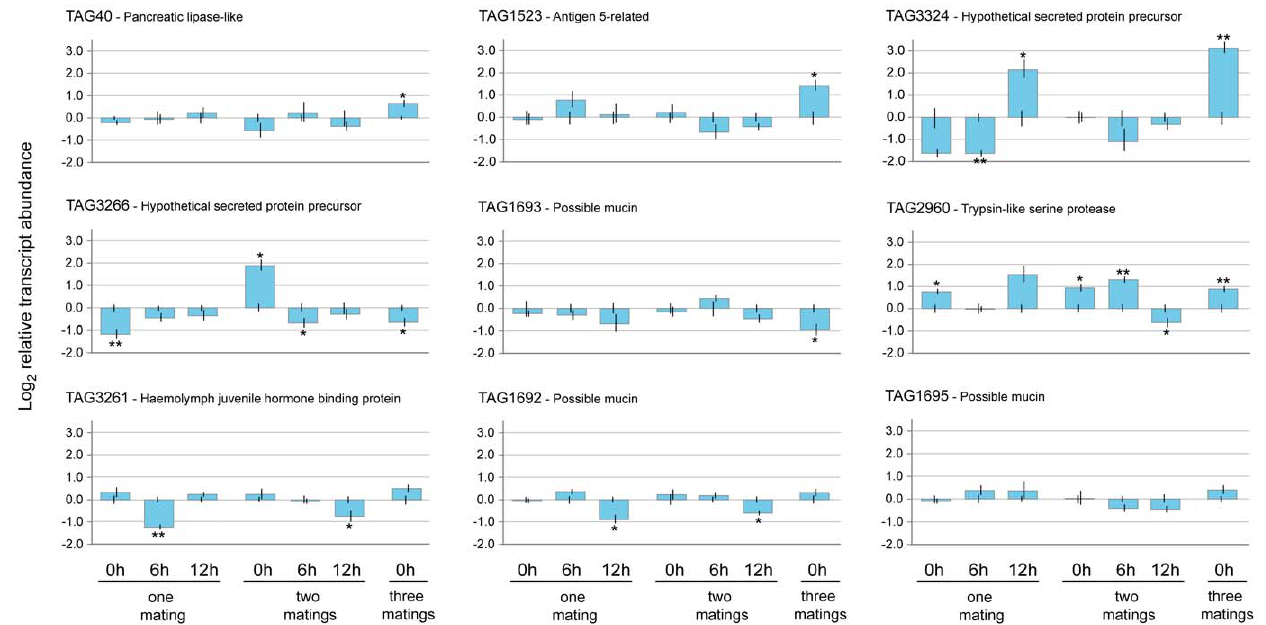
Figure 5. Differential transcript levels (Log 2 transformed fold changes) of nine putative secreted peptides in mated medfly males, compared to virgin individuals of same age. Transcript abundances were determined at seven different time-points (0, 6 and 12 h after the first and the second mating respectively, and 0 h after the third copula) compared to virgin males of the same age. Stars indicate significant differences in transcript abundances (*P , 0.05, **P , 0.01, ***P , 0.001, two-tailed t -test on three replicates) in the pairwise comparison between mated and virgin males.